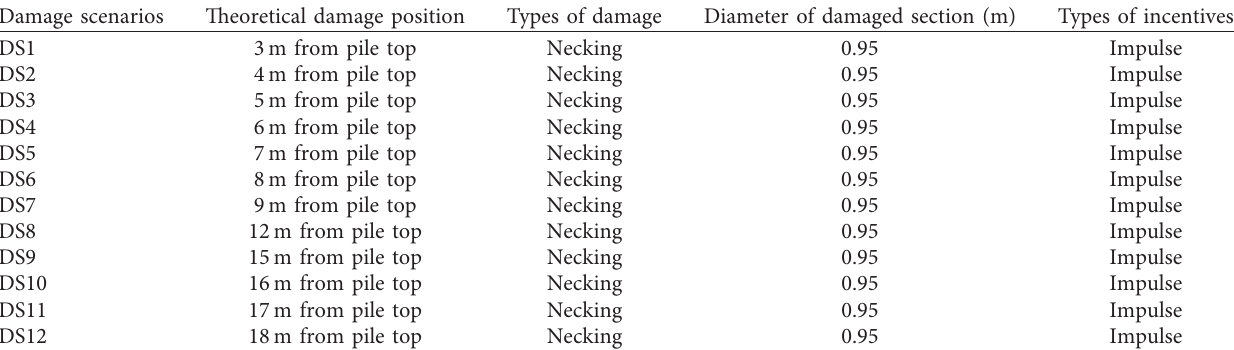
Figure 9: Time-phase angle curve with the frequency of 600Hz. Table 2: Damage scenarios of the simulated pile.